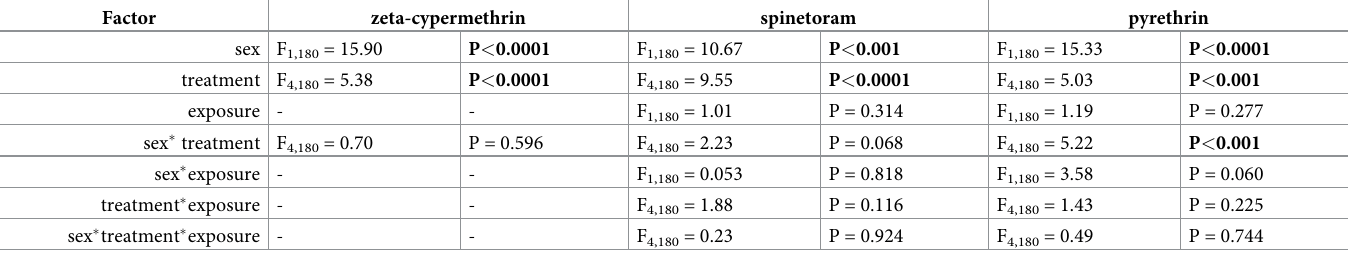
Table 3. Three-way ANOVA results for the effects of fly sex (male or female), treatment concentration (LC 0 , LC 10, LC 20, LC 30, LC 40 ) and type of exposure (single or double) on survival for each insecticide experiment. Bolded values indicate statistically significant p-values (P �